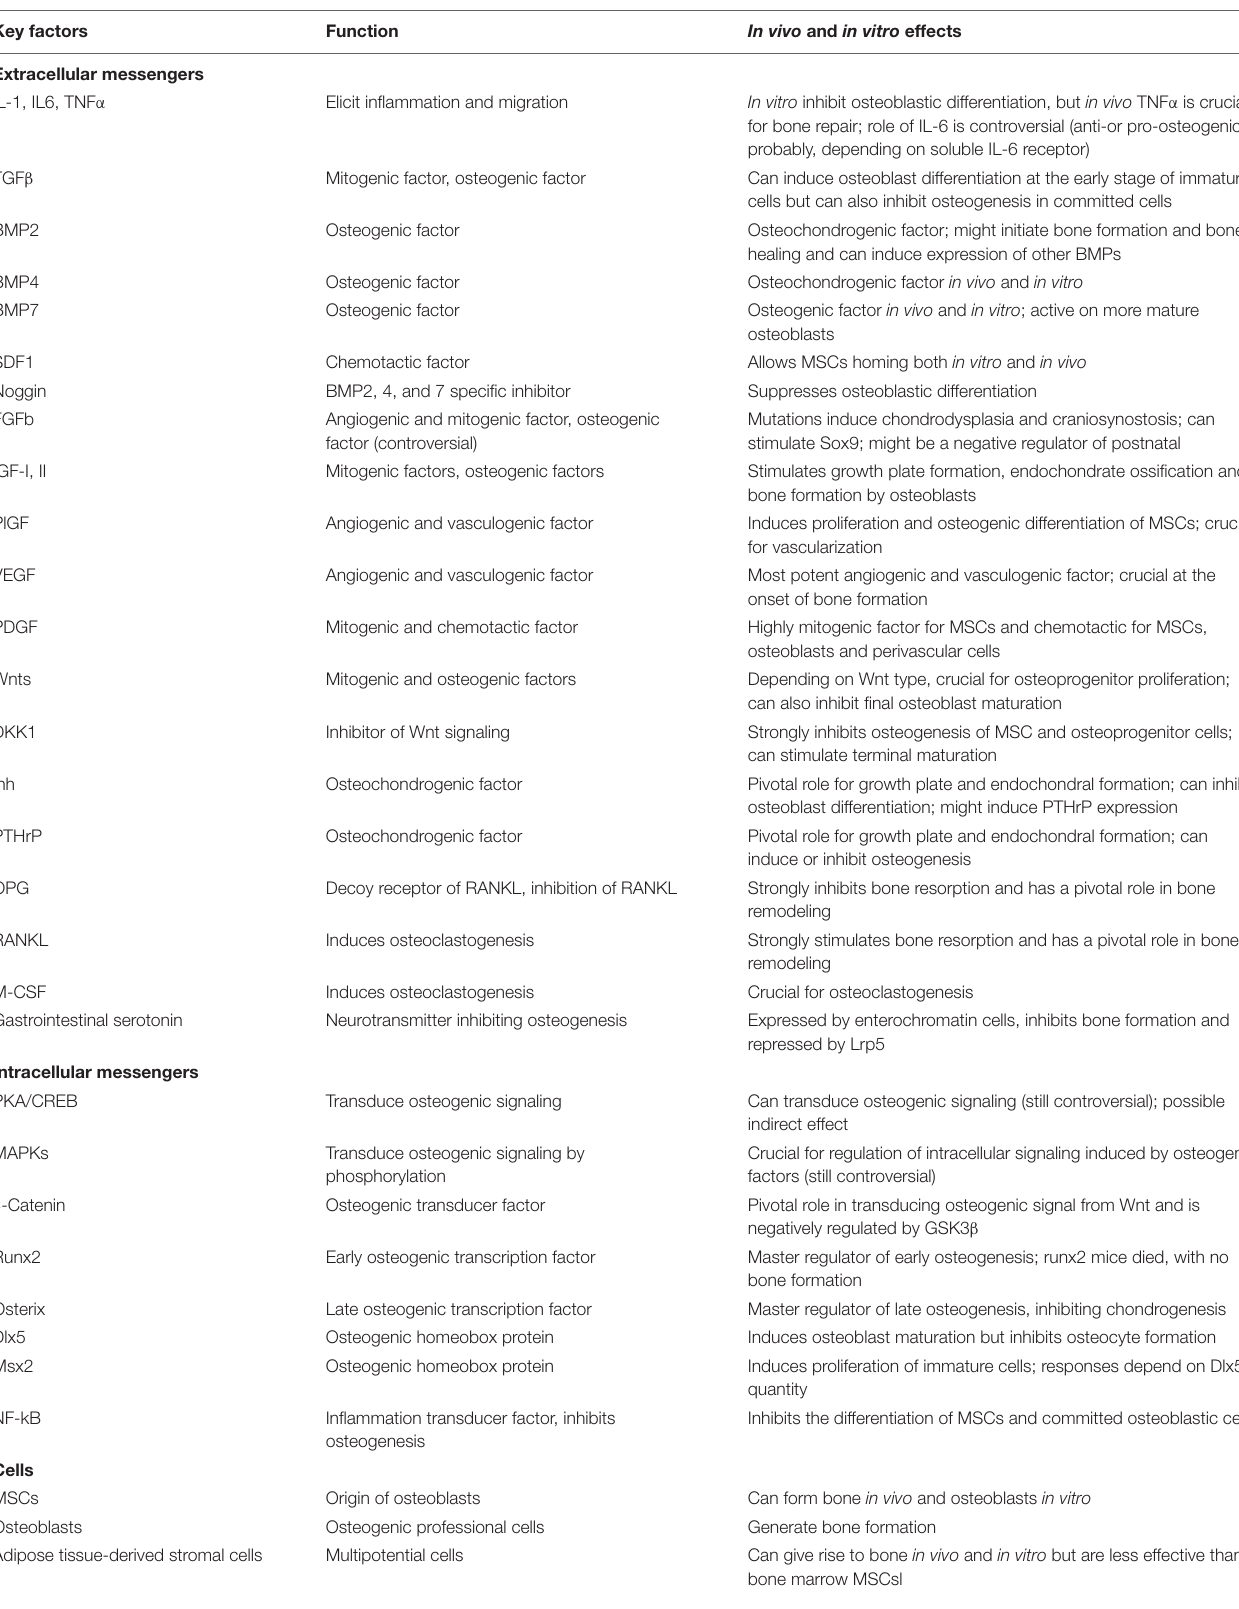
TABLE 1 | Key molecules and cells involved in bone repair. Key factors Function In vivo and in vitro effects Extracellular